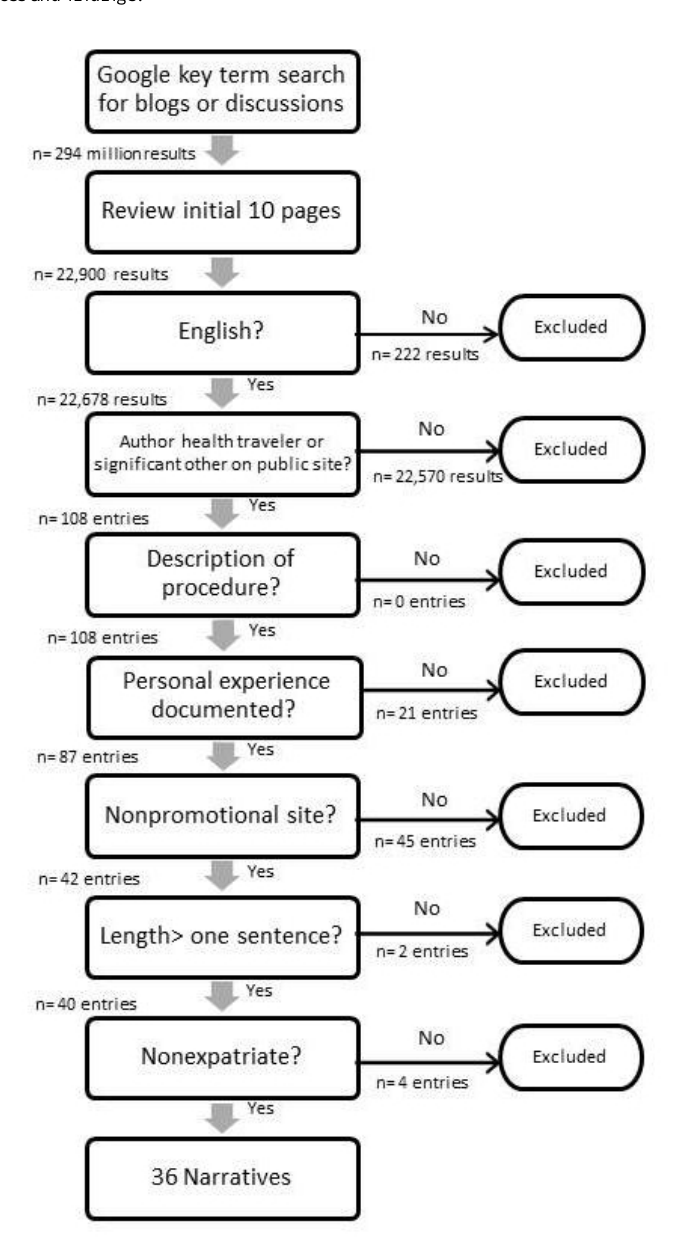
Figure 1. Steps in the narrative search process and